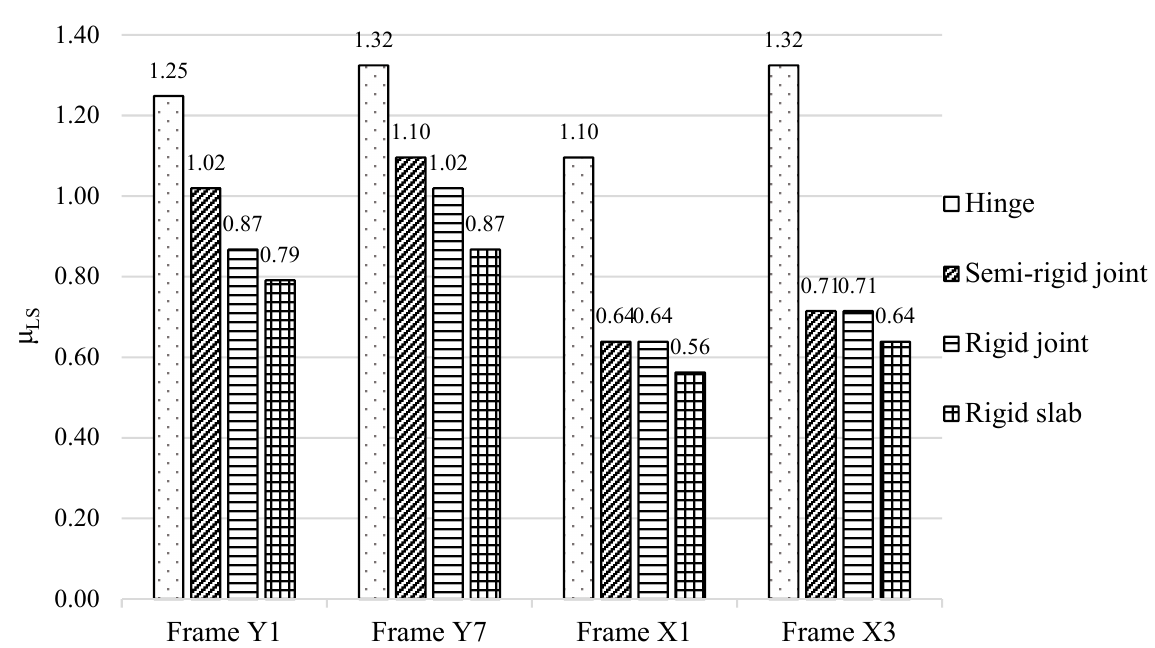
Figure 19. Damage factors of the warehouse with different connection types at the CP limit state.